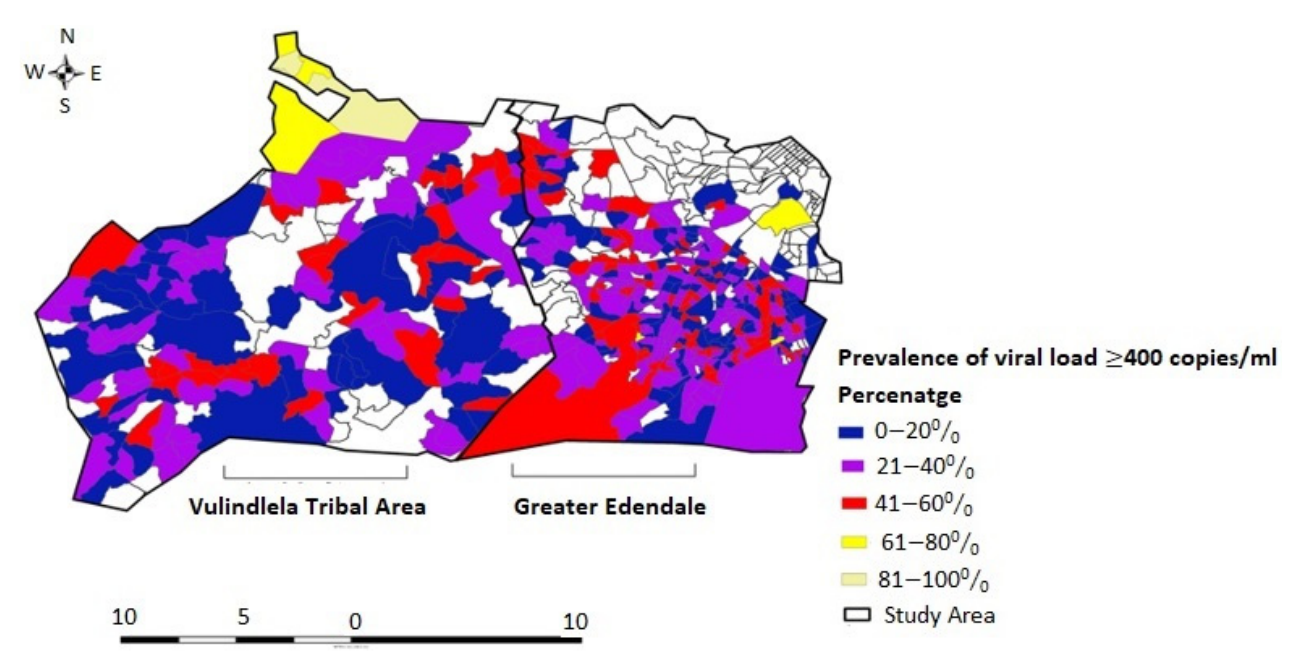
Figure 2. Observed prevalence map of unsuppressed HIV viral load among HIV-positive men and women in rural Vulindlela and peri-urban Greater Edendale area in the uMgungundlovu District, KwaZulu-Natal Province, South Africa. Geographic coordinate scale at five-kilometre radius. Table 2. Posterior mean and 95% credible interval for the Smooth-term variance components (SVC).